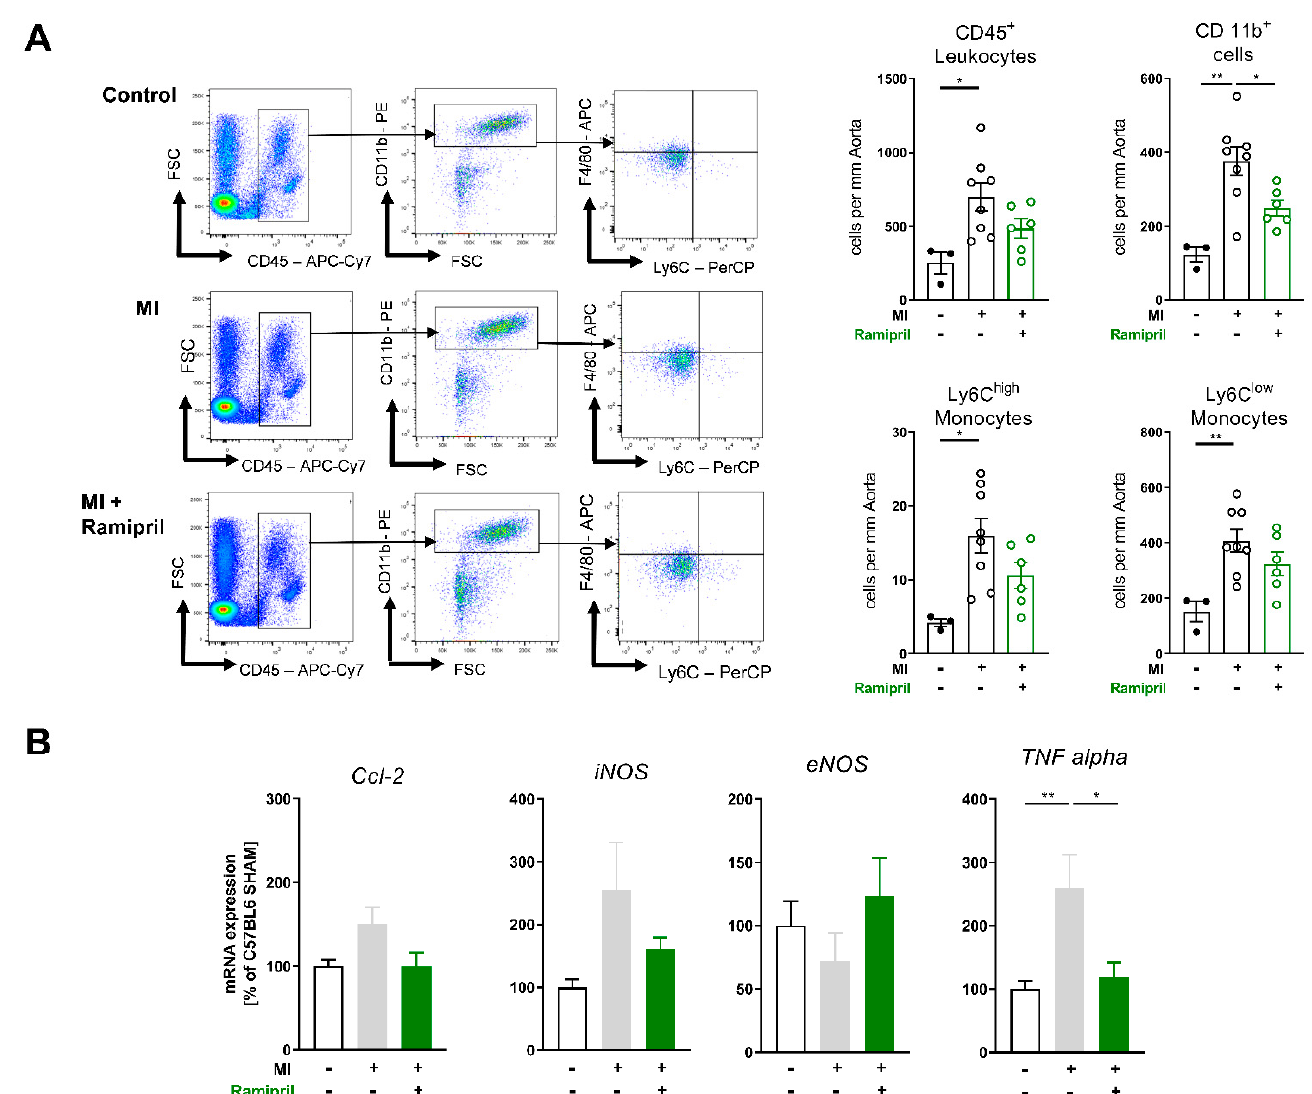
Figure 4. Ramipril limits vascular inflammation in chronic ischemic heart failure by attenuating myeloid cell infiltration. ( A ) Flow cytometry quantification of aortic tissue 28 days after MI vs. sham; left: representative FACS plots, right: quantification of leucocytes (CD45 +) , myeloid cells (CD45 + CD11b + ) and monocytes (CD45 + CD11b + Ly6G-Ly6C high / low) , n = 3–8 mice per group, mean + SEM, n = 3–8 mice per group; ( B ) mRNA expression of aortic tissue of Ccl-2, iNOS (Nos2), eNOS and TNFalpha 28 days after MI vs. sham (+Ramipril); mean+SEM, 1-way ANOVA or Kruskal–Wallis test with Dunn’s multiple comparisons test. * p < 0.05, ** p < 0.01.